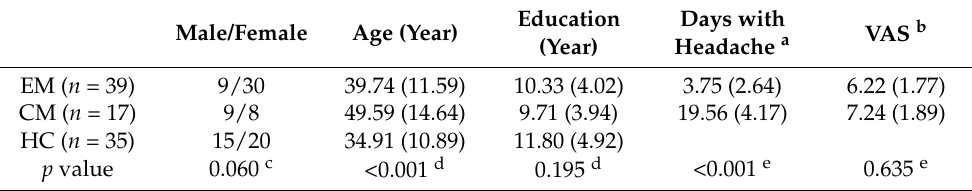
Table 1. Demographic and clinical characteristics of patients and healthy